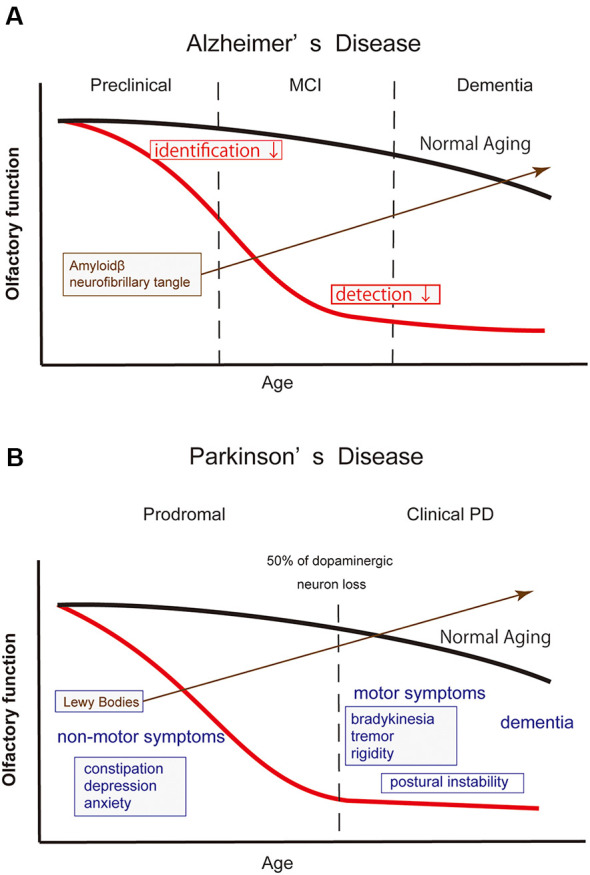
Schematic drawing illustrating the olfactory dysfunction and time course of Alzheimer’s disease (AD) and Parkinson’s disease (PD). In both neurodegenerative diseases, the emergence of olfactory dysfunction precedes their definite diagnosis. The red and black lines in the drawing indicate the time course of olfactory function in patients and normal elderly individuals, respectively. (A) In AD, olfactory dysfunction emerges in its preclinical phase when cognitive function is still preserved. At the time, however, the accumulation of amyloid β already begins in the brain structures, including in the olfactory pathway. Odor identification ability deteriorates first, followed by a worsening in odor detection. (B) Definite diagnosis of PD is made by the emergence of motor symptoms when approximately 50% of dopaminergic neurons are lost in the substantia nigra. Olfactory dysfunction emerges in the prodromal phase, along with other non-motor symptoms. Lewy bodies are already observed in the olfactory system, including the OB. In clinical PD, the severity of olfactory dysfunction does not appear to be correlated with the disease duration or disease stages, suggesting that the degenerative changes in the olfactory neural structures have progressed at the time of diagnosis.